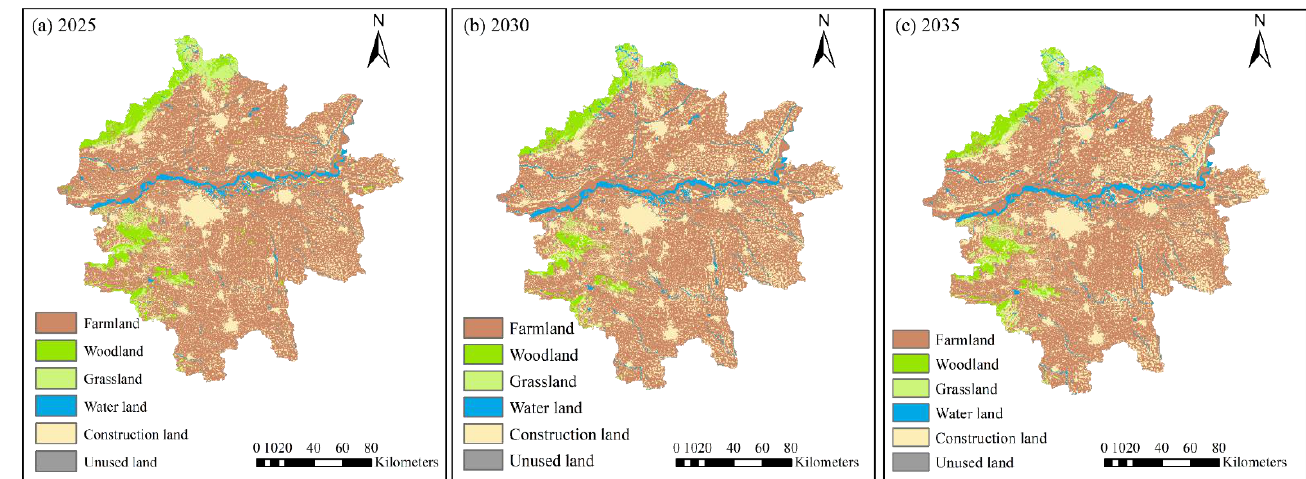
Figure 14. Land use simulation results for ( a ) 2025, ( b ) 2030, and ( c ) 2035.